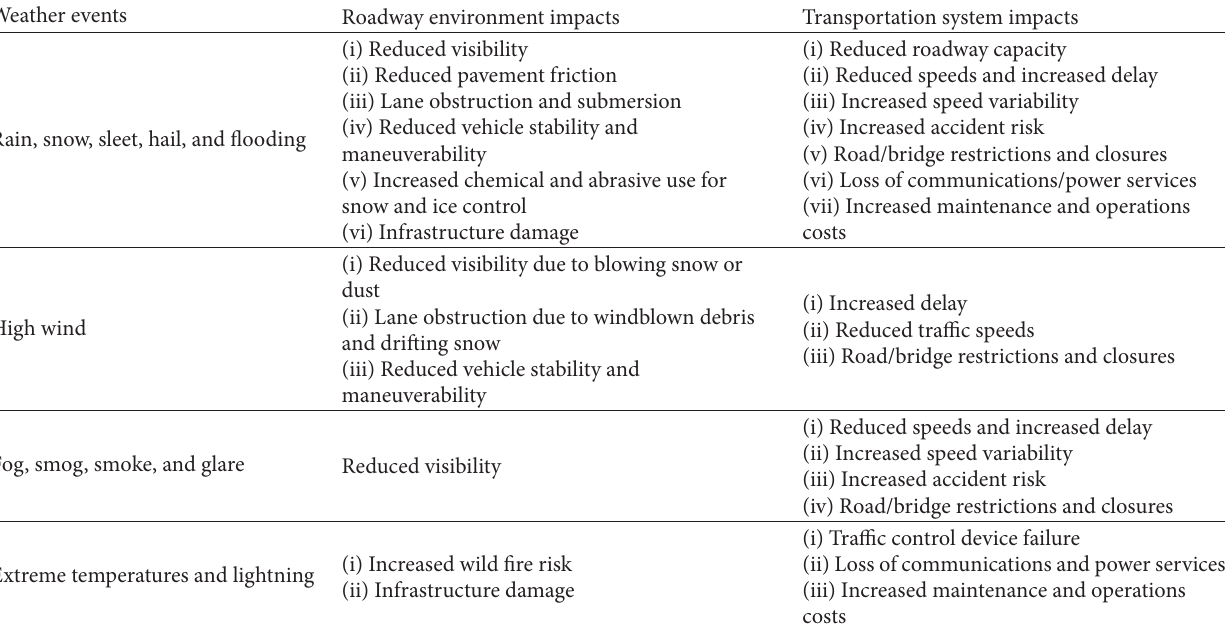
Table 1: Weather impacts on roadway environments and transportation